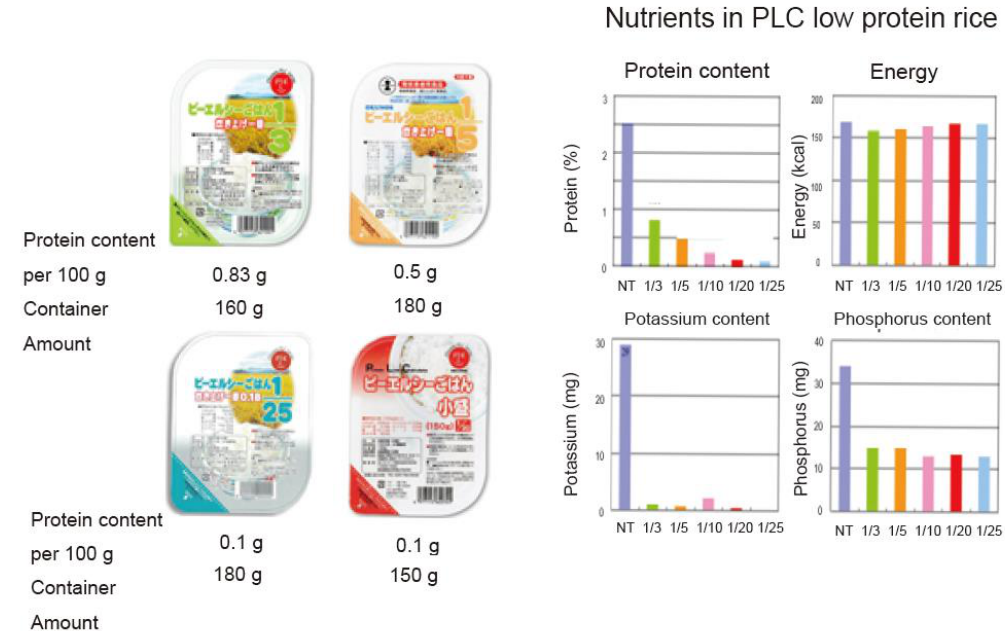
Figure 2. Various PLC rice products. The label claims that they are suitable foods for kidney disease patients. When launched in 1995, the first product contained 1/3 of the protein in WR. With continuing technological developments, the company achieved a reduction rate of 1/25 by 2007. As of 2020, the PLC rice series expanded to include ten products with different degrees of protein reduction, from one-third to one-25th, and two serving sizes (140 and 180